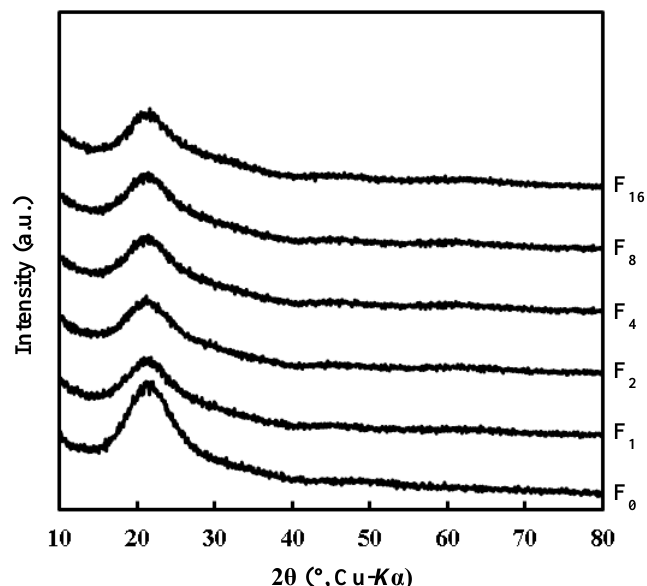
Figure 3. X-ray diffraction (XRD) patterns of precursor film F 0 and UV-irradiated films F x on quartz glass